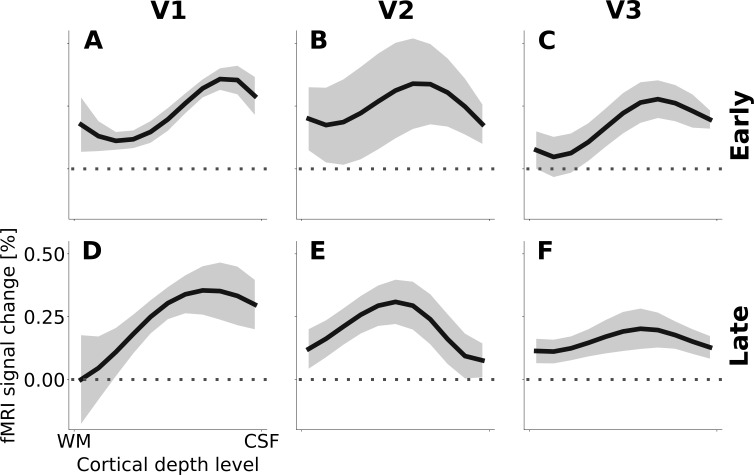
Cortical depth profiles of the apparent motion effect for the cortical representation of the stimulus centre.Similar to Figure 4, but separately for the early and late phases of the response. (A, B, C) The early response includes the second and third fMRI volumes after stimulus onset (i.e. ~2 to~6 s after stimulus onset). (D, E, F) The late phase comprises the last two fMRI volumes during which the stimulus was presented (~8 to~12 s after stimulus onset). The apparent motion effect was defined as the relative signal change associated with the condition contrast ‘motion induction’ (Figure 1A) minus ‘dymanic control’ (Figure 1C). Shading represents the standard error of the mean (across subjects).